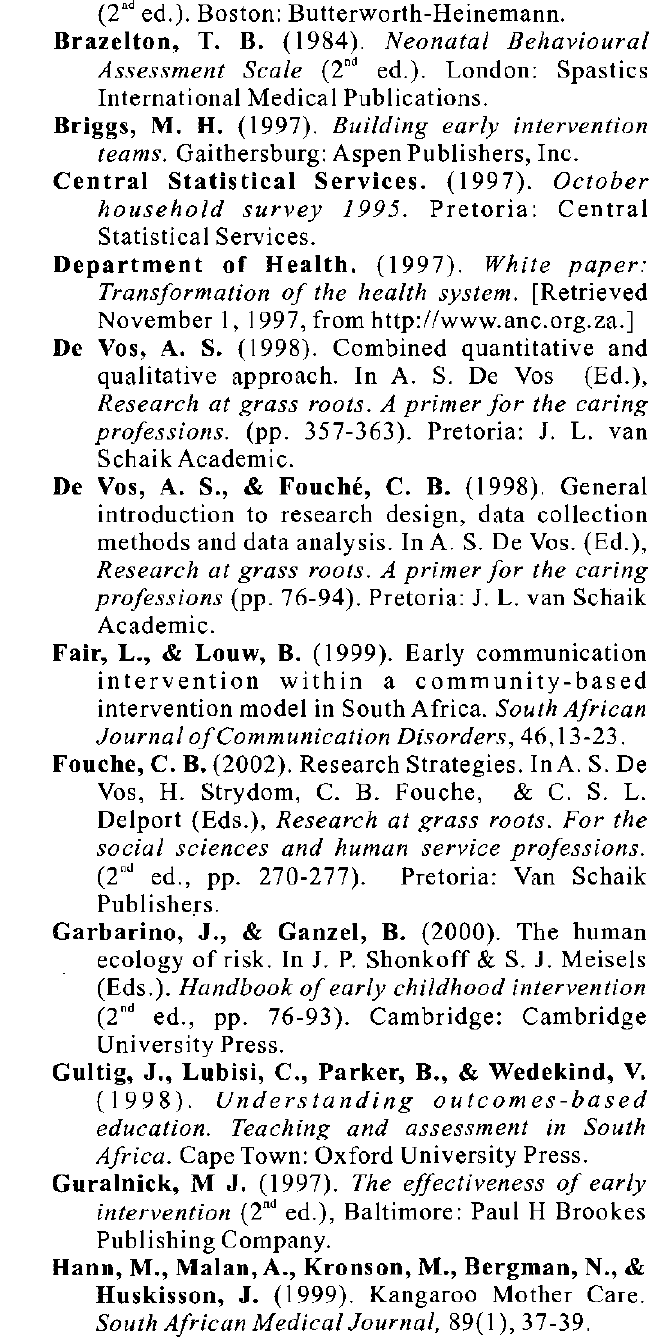
Figure I: Interdependent components of authentic learning experiences in ECI clinical